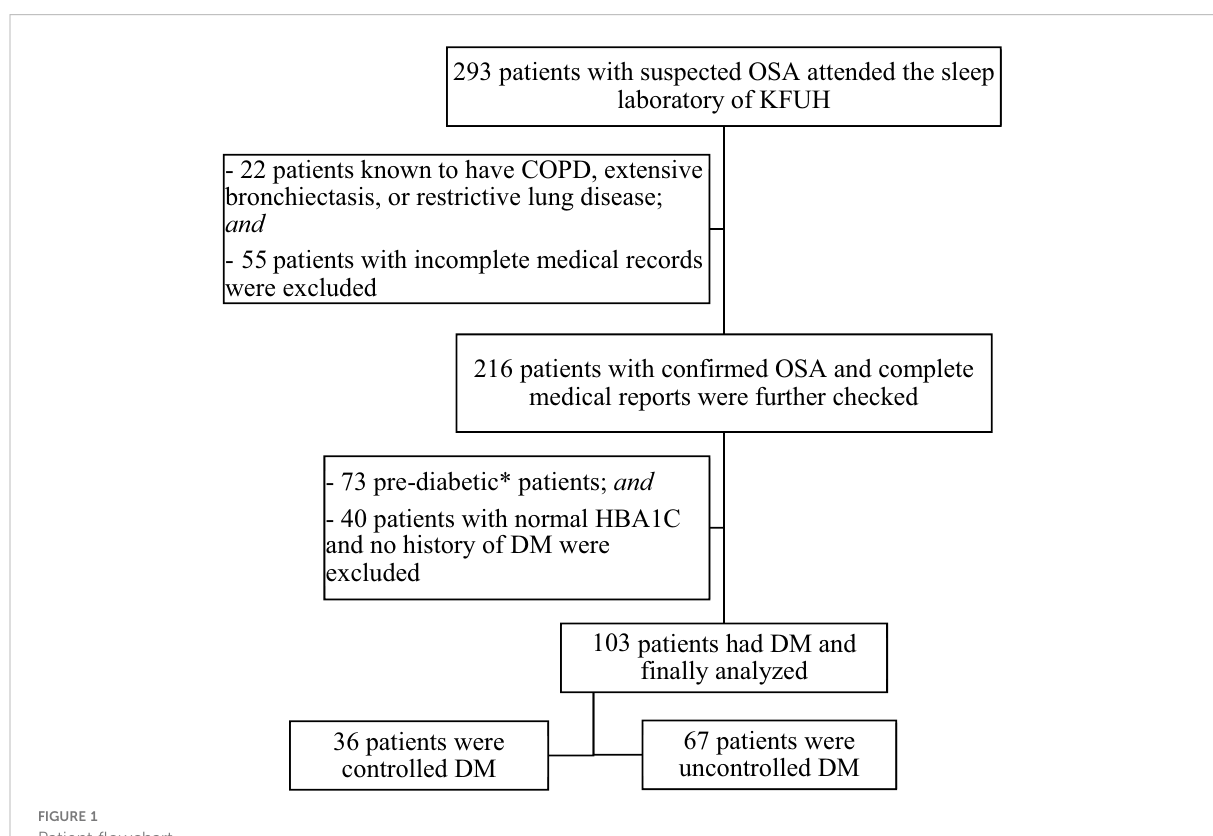
FIGURE 1 Patient fl